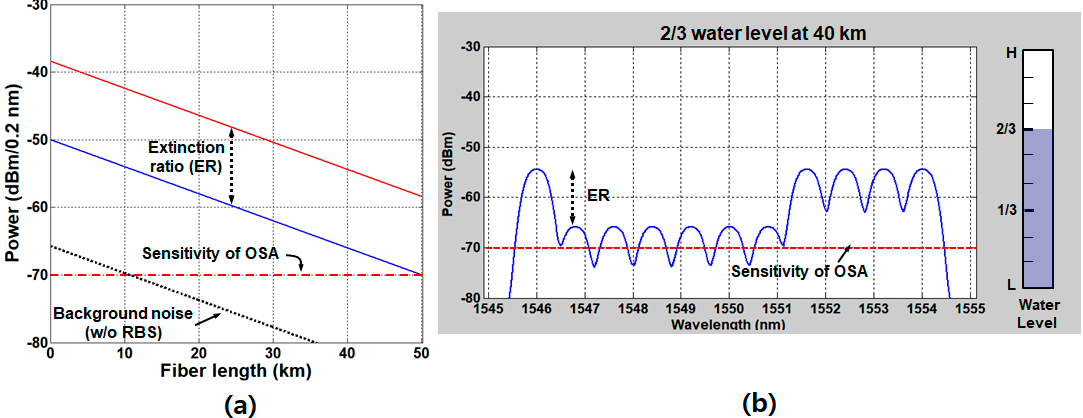
Figure 12. ( a ) Received optical power density as a function of the fiber length after the RBS effect is mitigated, and ( b ) the optical spectrum of the 2/3-full water level (6 height steps) at a 40-km fiber length. Adapted from Lee et al. [50].